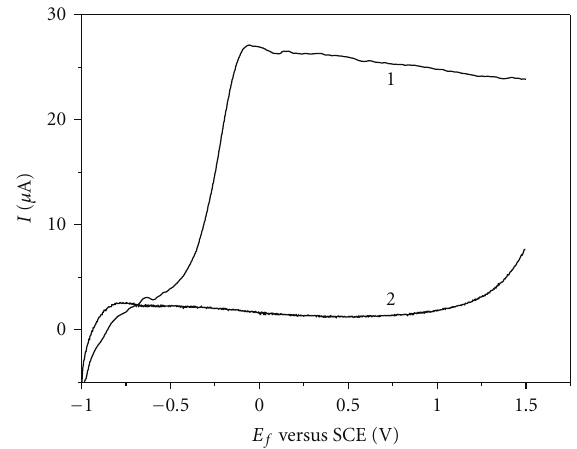
Figure 3: Voltammetric profiles for the growth (curve 1) and re- growth (curve 2) of the oxide film grown on Ti-grade 2 up to E f 1.5V, in PBS solution, at 50mV · s − 1 and 25 ◦ C.